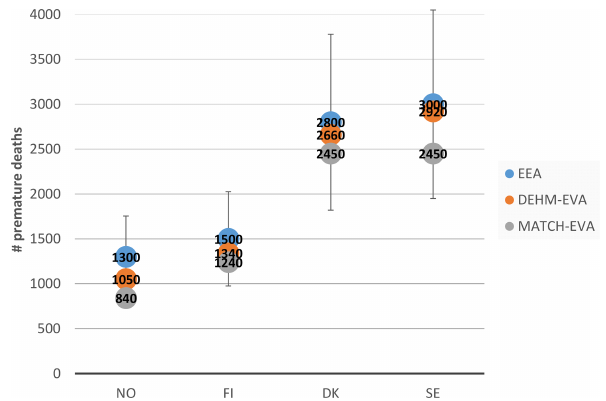
Figure 6. Comparison between the assessment of premature deaths reported by EEA for 2015 and the current assessment (base case 2015) for effects related to PM 2 . 5 exposure. The EEA number in- cludes an error bar displaying the assumed uncertainty ( ±